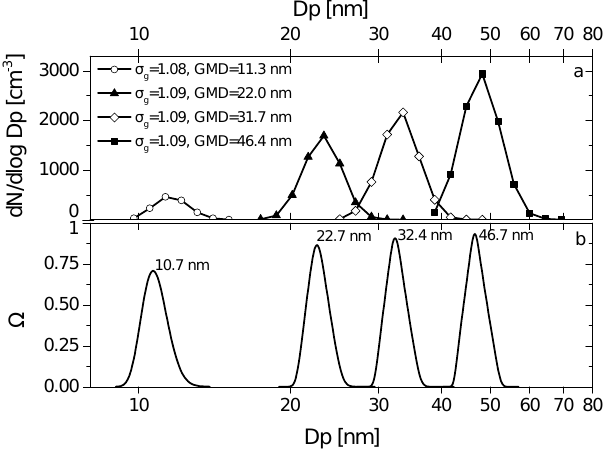
Fig. 3. Comparison of the performance of the rDMA coupled to an SMPS system (a) with theoretical transfer functions (b) . A sheath flow of 4 SLM and voltages of 116, 504, 1003 and 2000V resulted in geometric mean diameters measured by an SMPS system of 11.3, 22.0, 31.7 and 46.4nm, respectively. The theoretical transfer func- tions peak at 10.7, 22.7, 32.4 and 46.7nm, respectively.